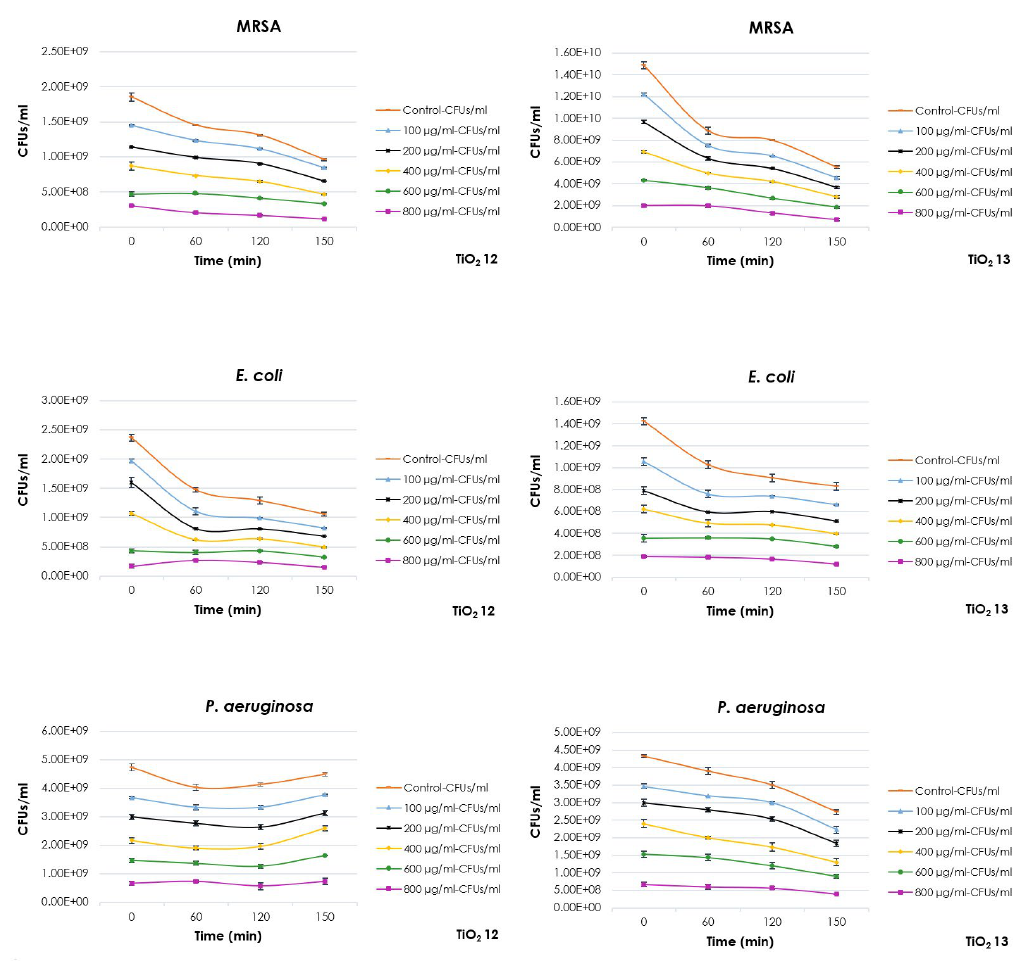
Nanoparticles with particle size between 4-5 nm against MRSA, P. aeruginosa 2